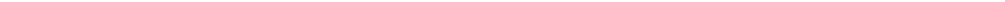
Fig. 1 Microtubule depolymerization induces the apical junctional complex in colon carcinoma cells. a Phase-contrast images of HT29 cells. Cells were treated with 10 μ M paclitaxel, 10 μ M nocodazole, or 10 μ M podophyllotoxin in 0.1% DMSO for 1 h. Control cells were treated only with 0.1% DMSO throughout the experiments. b Immunostaining for ZO-1, E-cadherin and α -tubulin at the apical plane of HT29 cells treated with 10 μ M nocodazole for 1 h. This condition for nocodazole treatment of HT29 cells was used throughout the experiments unless otherwise noted. Boxed area is an example of discontinuous ZO-1/E-cadherin distributions. c Lateral views of HT29 cells stained for ZO-1, E-cadherin and DNA (with DAPI). d Relative ZO-1 positive areas. See Methods section for details of quanti fi cation. n = 86 fi elds for both control and nocodazole-treated HT29 cultures, pooled from three independent experiments. n = 61 for both control and nocodazole-treated Colo205 cultures, n = 68 for both control and nocodazole-treated LS180 cultures, and n = 67 and 64 for control and nocodazole-treated SW620 cultures, respectively, pooled from two independent experiments. Mean ± SEM. **** P < 0.0001 by two-tailed Mann – Whitney U -test. e Time-lapse images of HT29 cells treated with 20 μ M nocodazole. Images are identical to Supplementary Movie 1. f Immunostaining for αΕ -catenin, β -catenin, l-afadin, and Par3 in HT29 cells. Arrows indicate examples of junctional areas that lack catenins. g Staining for ZO-1, E-cadherin and DNA in Colo205, LS180, and SW620 cells treated with nocodazole for 1 h. Relative ZO-1 positive areas are shown in d . h Colo205 cysts formed in Matrigel, stained for F-actin, ZO-1 and DNA. The cells were cultured for 3 days, and then treated with 0.2% DMSO or 20 μ M nocodazole in 0.2% DMSO for 3 h. The ratio of cysts with a single, multiple and no lumens is shown. n = 87 cysts for control and 93 cysts for nocodazole treatment, pooled from two independent experiments. Scale bars, 100 μ m a ; 10 μ m b – h . See also Supplementary Fig.